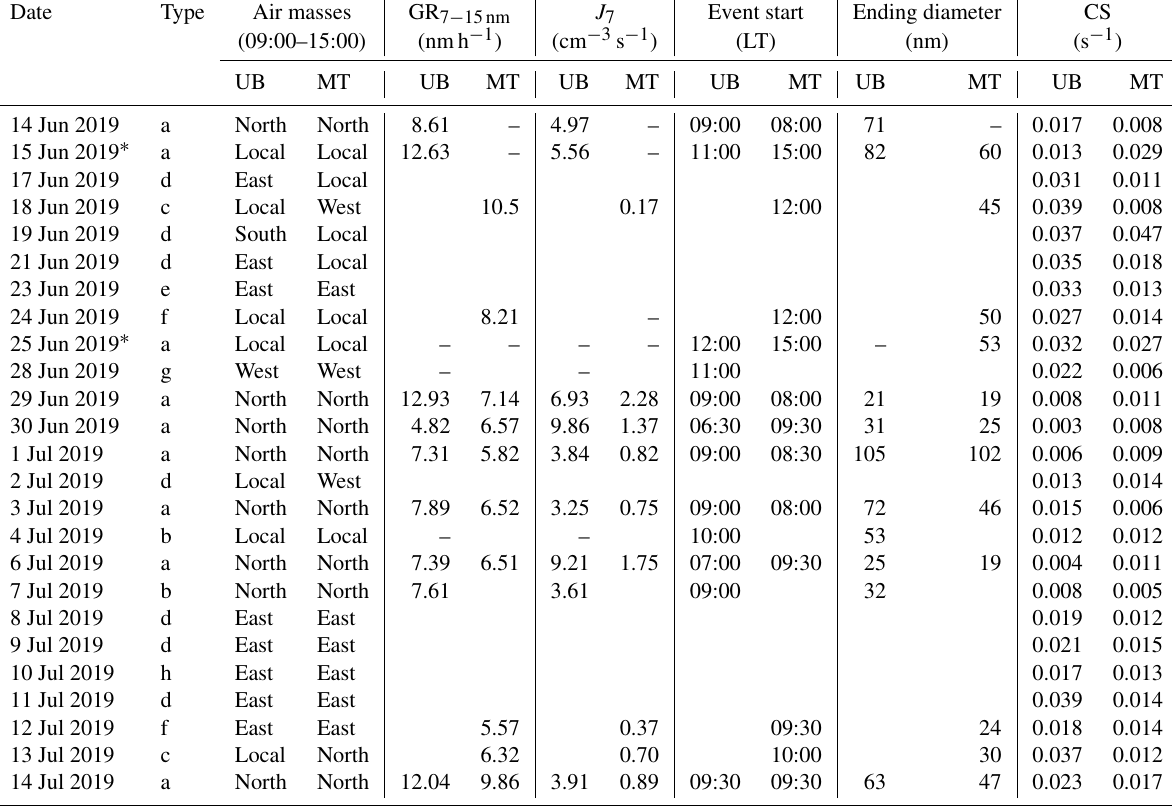
Table 1. NPF event and non-event days during our observation at both